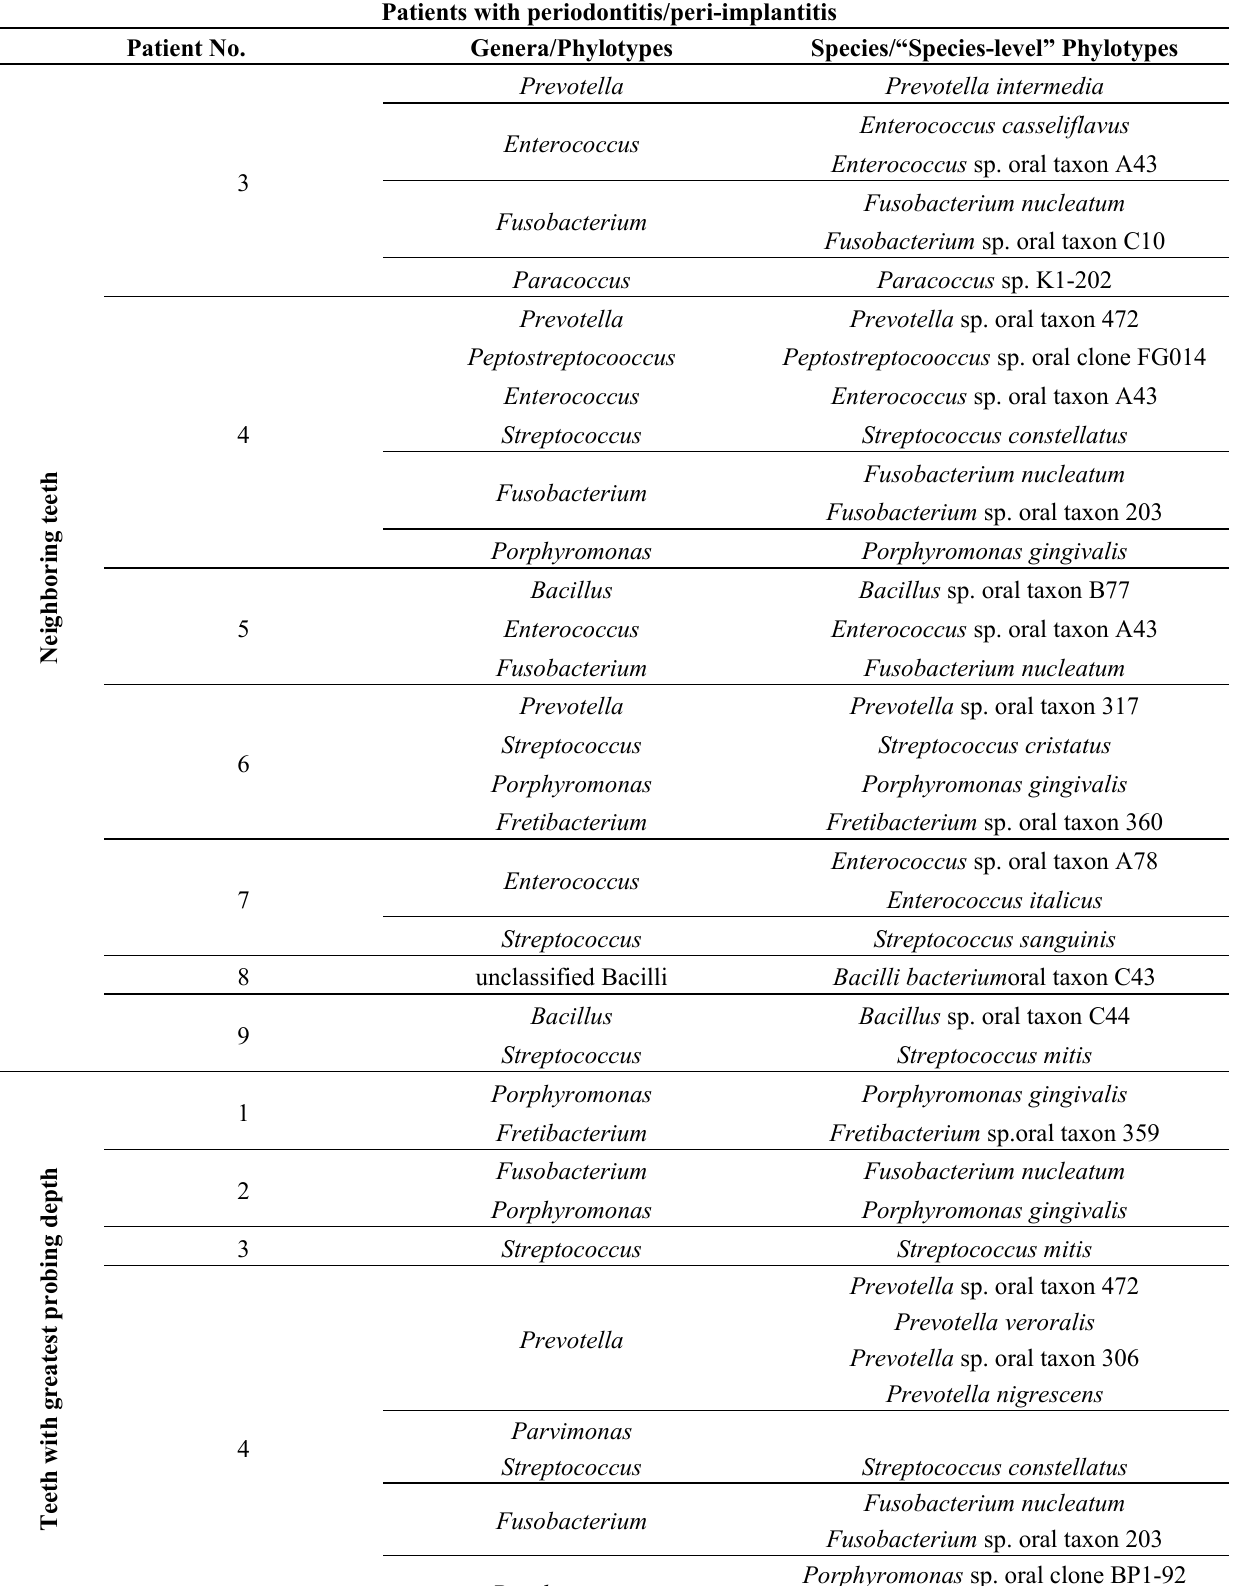
Table 5. Cont. Patients with periodontitis/peri-implantitis